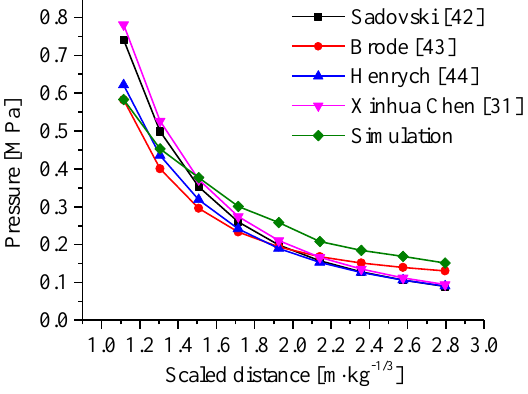
Figure 4. Comparison of theoretical and numerical data in air explosion at the height of 2 m.